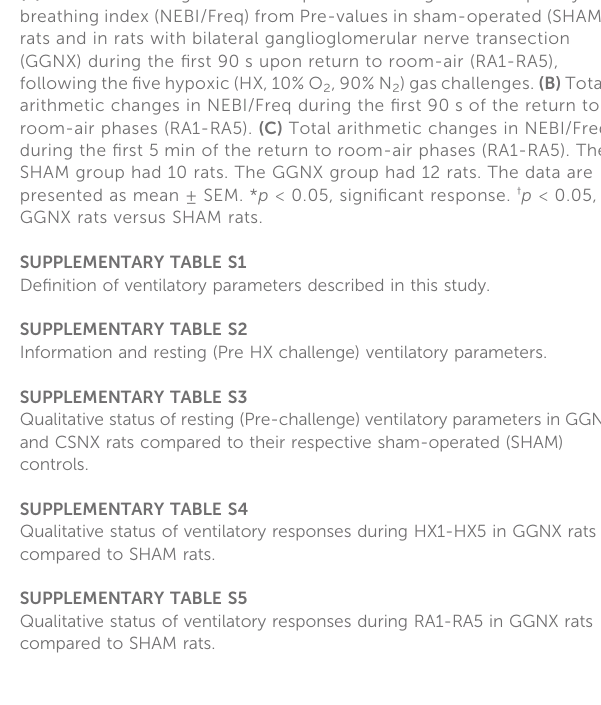
compared to SHAM